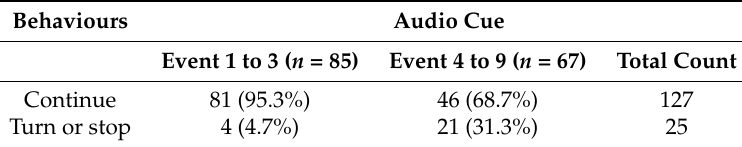
Table 2. Count of behaviours displayed by sheep in response to the audio cue ( n = 152) during associative training, n is the number of approaches to the exclusion zone. Proportions are displayed in brackets.